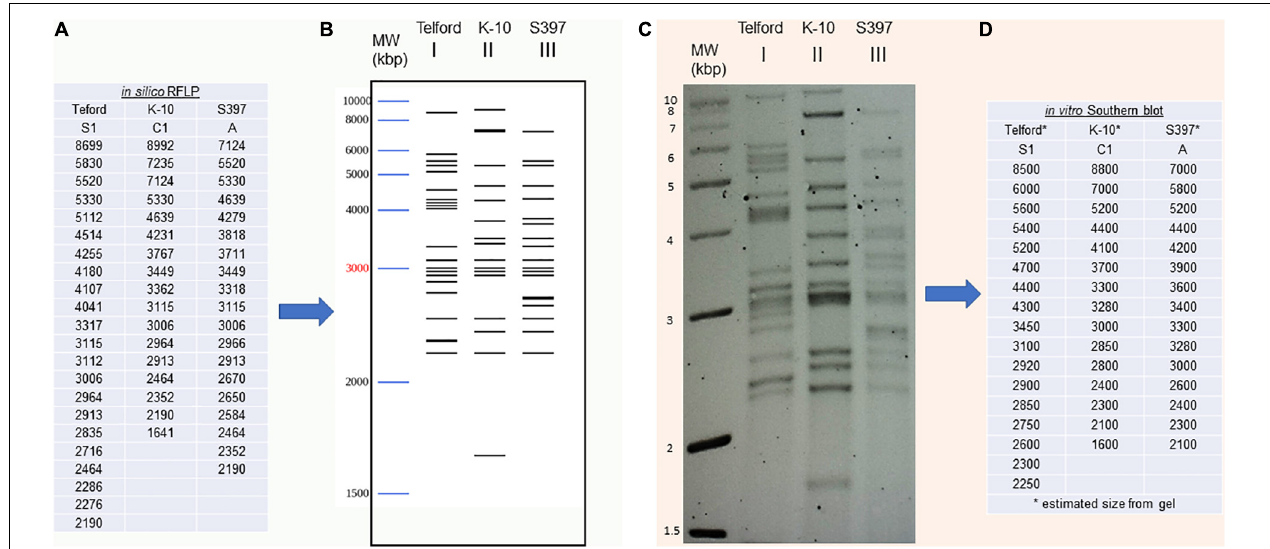
FIGURE 3 | IS 900 restriction fragment length polymorphism (RFLP) “ in vitro ” versus “ in silico ” (A) An in silico RFLP analysis was developed using complete genomes. This automated procedure identified the Bst EII restriction sites to obtain the exact size of all DNA fragments carrying a copy of the IS 900 sequence. IS 900 RFLP profiles were compared using fragment sizes (A) or (B) by digital visualization of the restriction fragments separated according to their size by mimicking their migration in agarose gel. (C) The IS 900 RFLP profiles obtained by classical Southern blot method and hybridization to IS 900 were used to find the approximate fragment sizes by band analysis software (D)